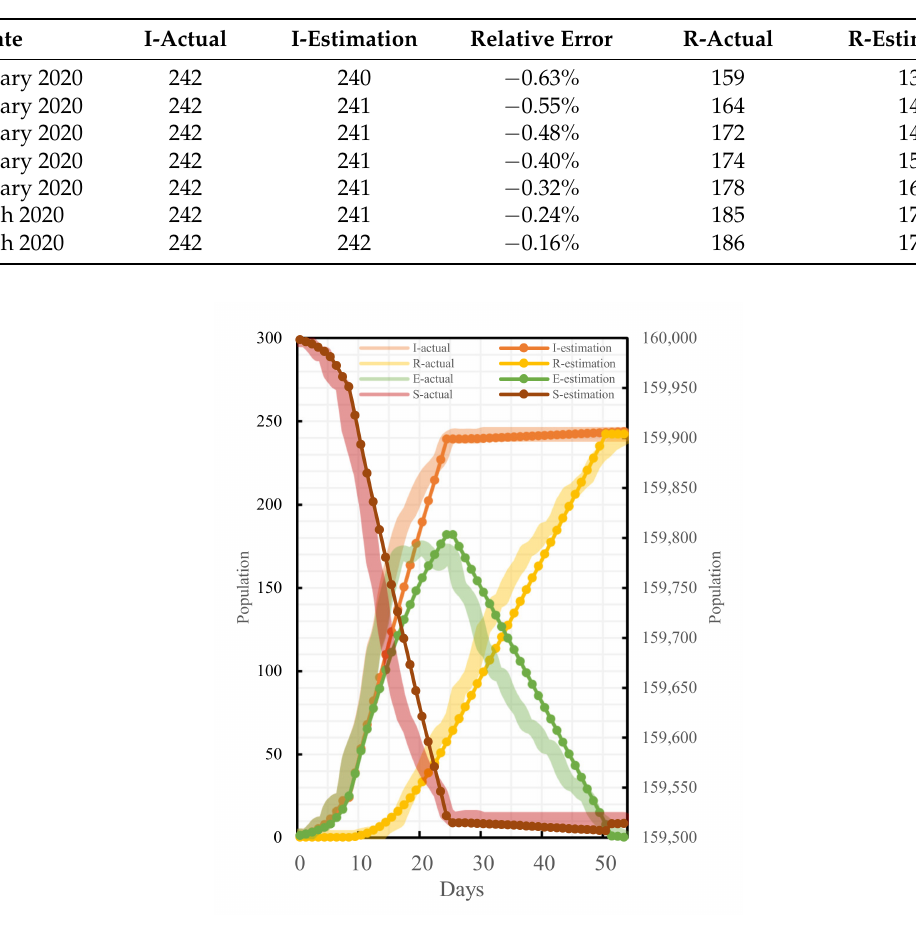
Table 6. Relative error analysis of some data.